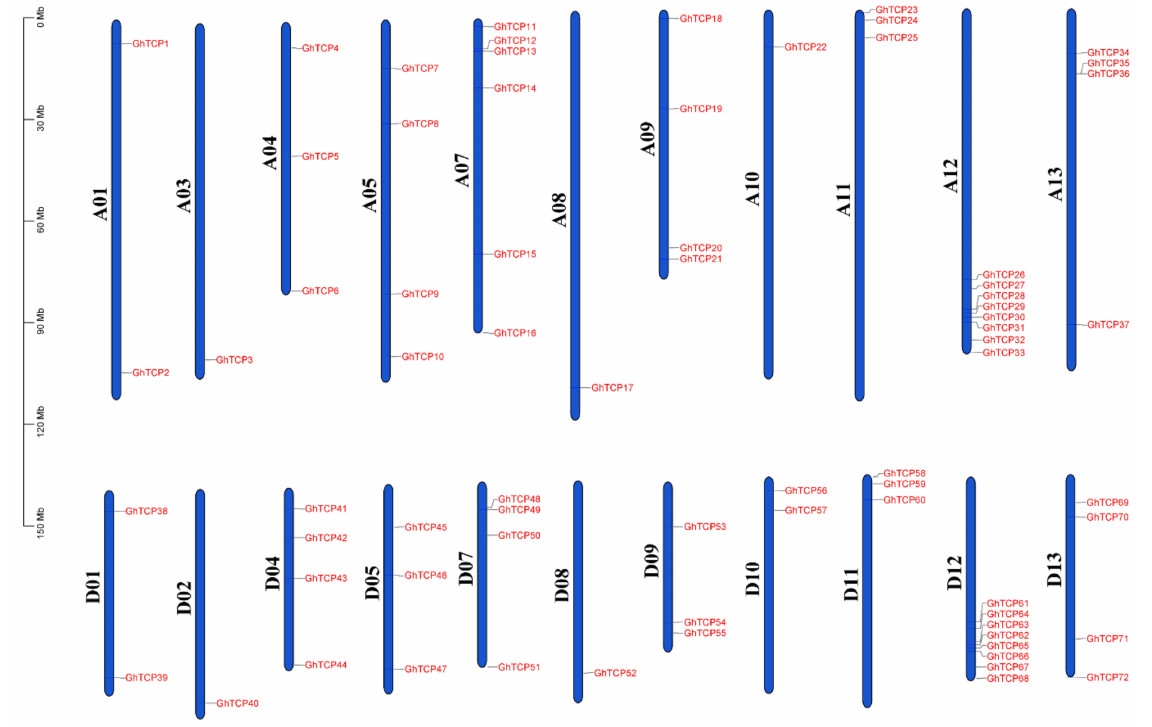
Figure 4. Chromosomal distribution of TCP genes of G. hirsutum . The scale is in megabases (Mb). Chromosome numbers are indicated at the left of each chromosome.